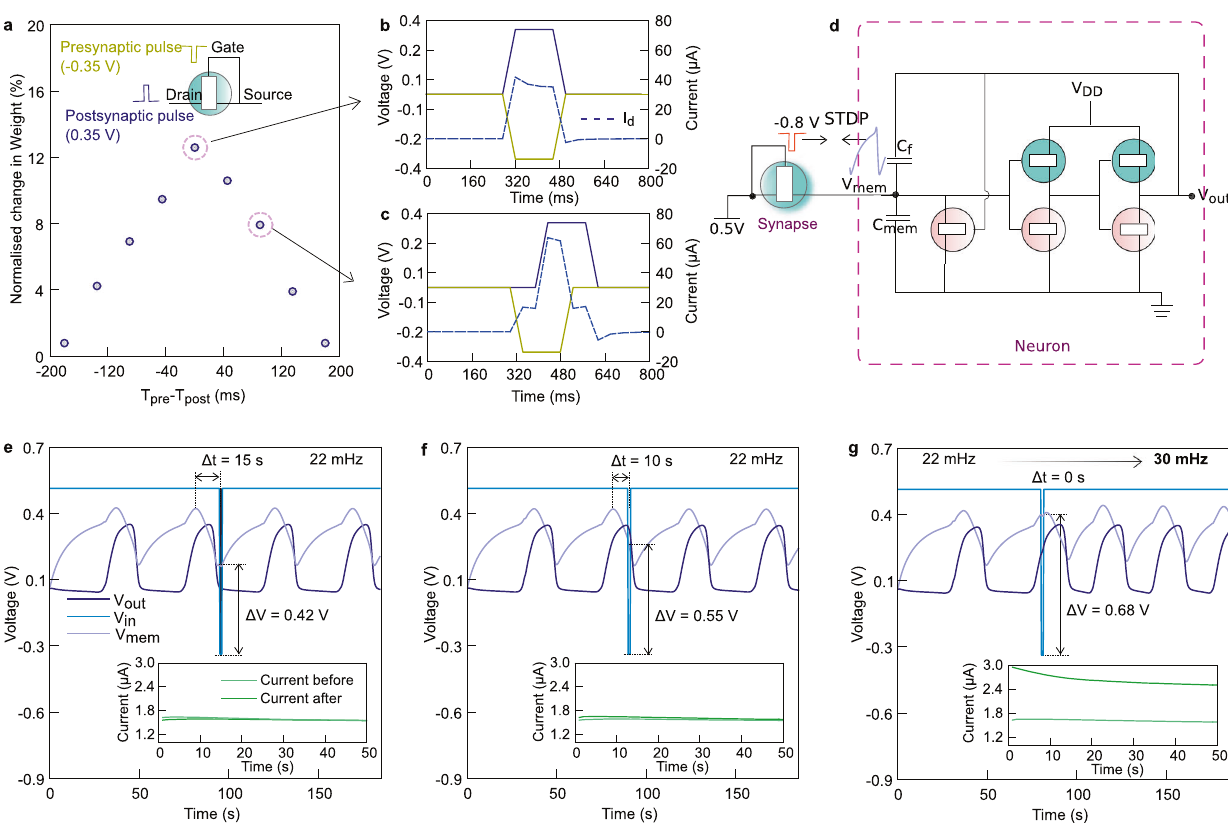
Fig. 4 Integrated organic electrochemical neurons and synapses. a Symmetric Hebbian STDP in the arti fi cial synapse. Source and gate electrodes are connected together and form the presynaptic input, while the drain is the postsynaptic output. b , c Characteristic voltage waveforms at Δ t ( T pre - T post ) = 0 and 90 ms respectively. d Schematic showing the connection of ETE-PC based synapse with the neuron to enable STDP in the system — the presynaptic input is a pulse of − 0.8 V (1 s) and the V mem is the postsynaptic feedback. e – g represent the change in synaptic conductivity and the resulting change in frequency of the neuron for Δ t = 15, 10, and 0 s. C mem and C f of 100 μ F are used in this setup to make the neuron fi re at a lower rate for the ease of adjusting the spike delays between pre- and postsynaptic